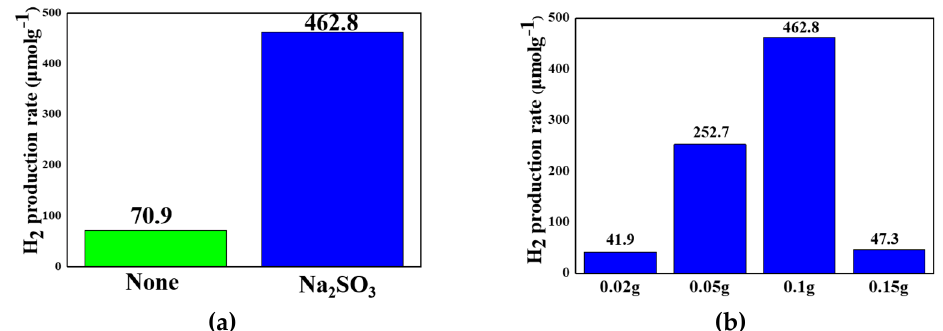
Figure 7. Hydrogen production efficiency of the PC004 ( a ) without and with Na 2 SO 3 addition, and ( b ) as a function of catalyst powder loading after 6 h of visible light irradiation.